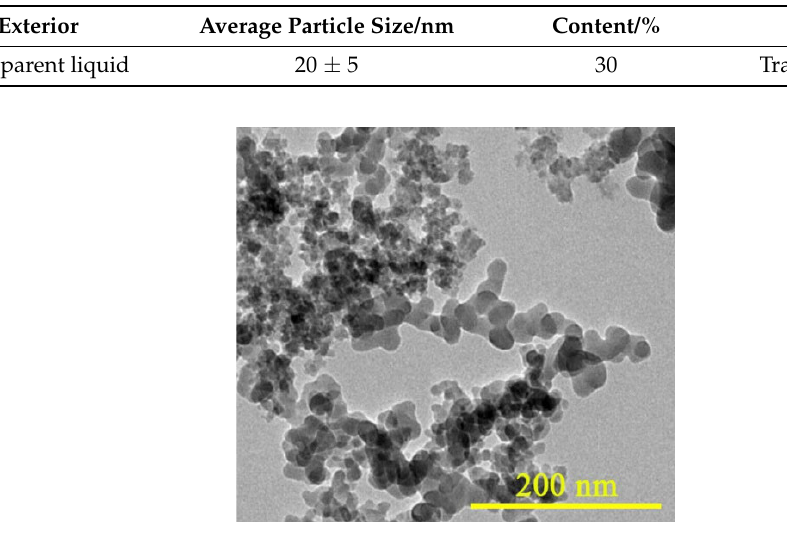
Table 2. Physical characteristics of NS.